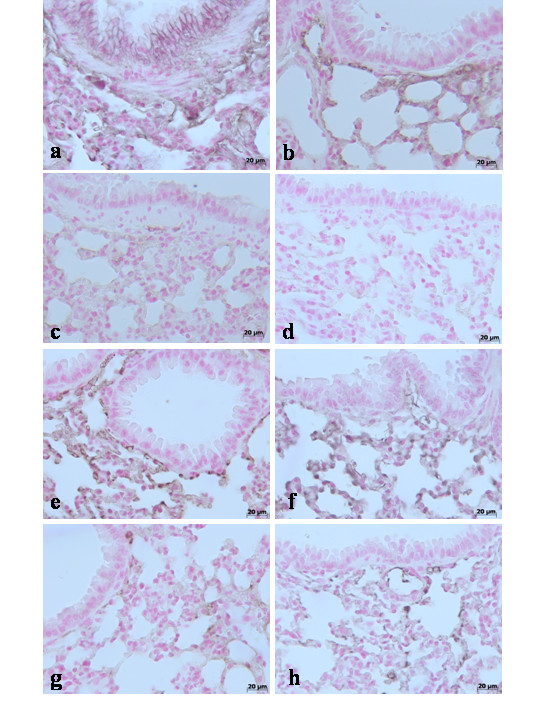
Immunohistochemical localization of β-catenin in the lung. In lung tissue sections collected at 24 hours from sham WT mice (a) and from sham TNF-αR1KO mice (b), β-catenin were uniformly and continuously distributed along the alveolar epithelium and the vascular endothelium. On the contrary, a significant disruption of immunohistochemical localization signal for β-catenin was observed in the lung tissues sections of carrageenan-treated WT mice at 4 h (c) and at 24 hours (d) after carrageenan. In lungs of carrageenan-treated TNF-αR1KO mice was found less irregular distribution pattern of β-catenin at 4 h (e) and at 24 hours (f) after carrageenan. Similarly, the treatment of WT mice with Etanercept (5 mg/kg administered s.c. 2 h prior carrageenan) were able to prevent carrageenan-induced distribution alteration of β-catenin at 4 h (g) and at 24 hours (h) after carrageenan. Figure is representative of at least 3 experiments performed on different experimental days.